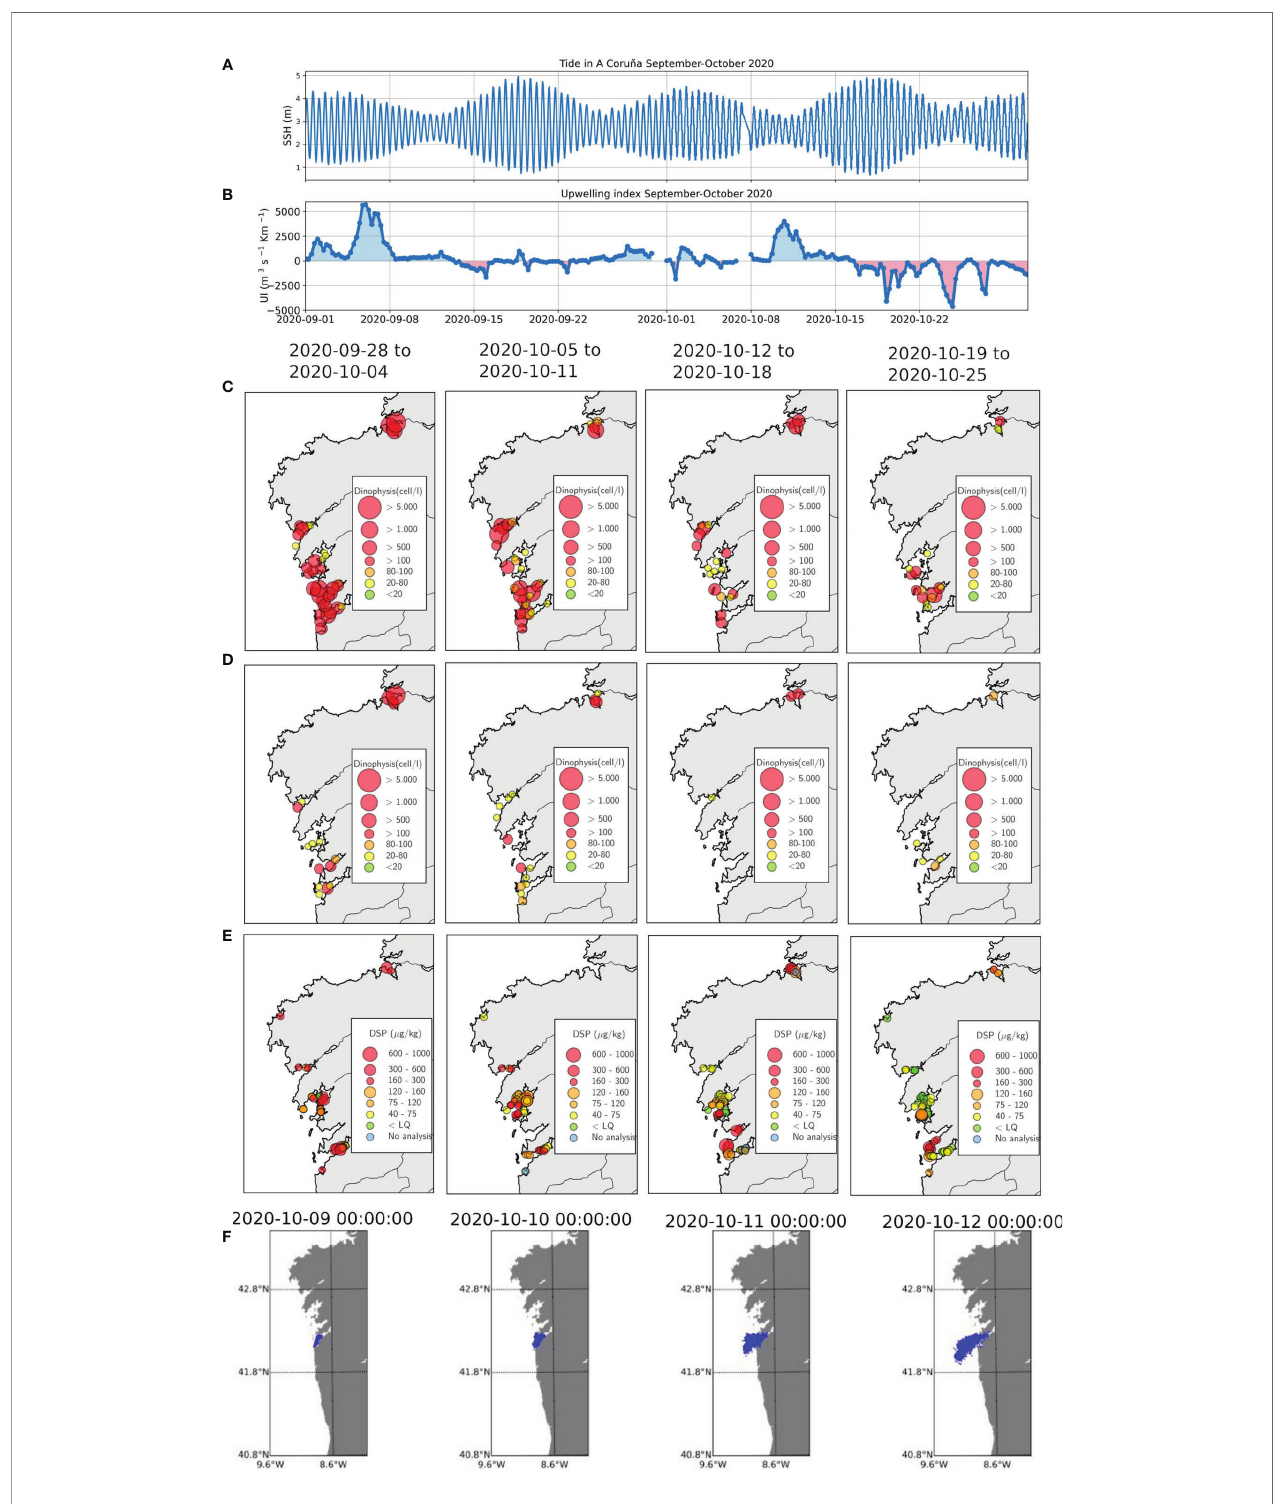
FIGURE 8 | Results of the PRIMROSE forecasts and data from the weekly Galician monitoring program in October 2020: (A) Tides at A Coruña in September- October 2020, (B) Upwelling index in September-October 2020 (C) Dinophysis acuminata (D) Dinophysis acuta and (E) DSP toxins (F) Particles released in the Ria de Vigo from 9-12